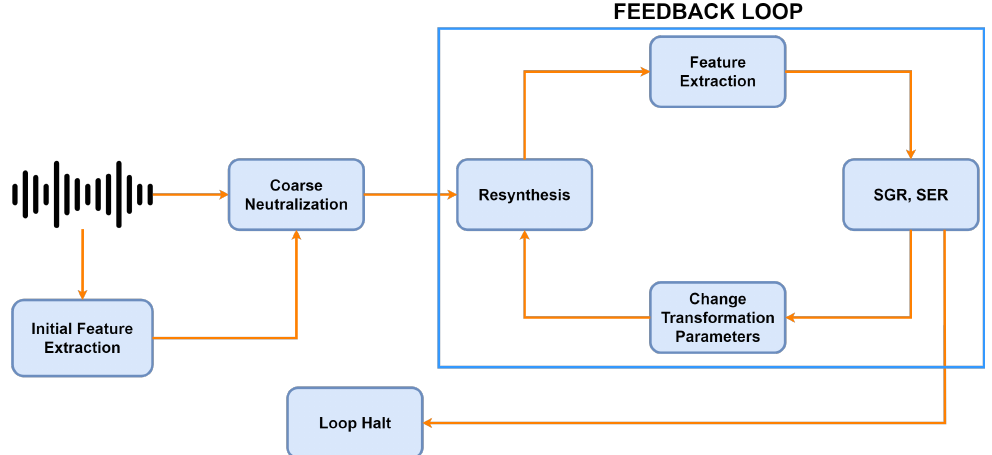
Figure 6. Diagram of our proposed gender neutralization